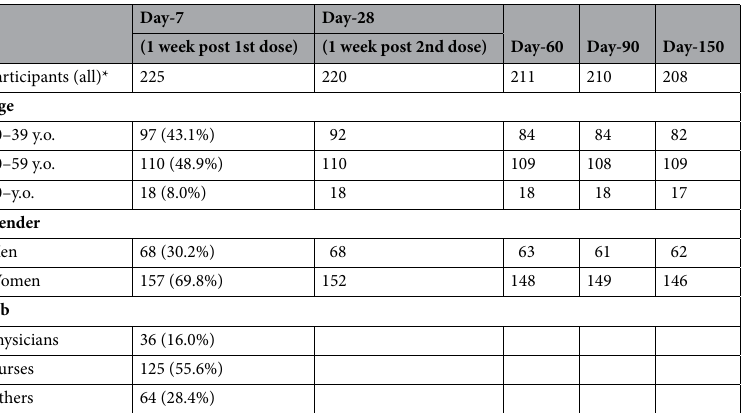
Table 1. Demographic characteristics of the participants. *None of the participants were in immunodeficient states or were receiving immunosuppressants or steroids. Two participants had previously experienced SARS-CoV-2 infection and were excluded from the present study since day-28. None of other participants experienced COVID-19-related symptoms and proved to be negative for antibodies against serum SARS- CoV-2 nucleocapsid throughout the study